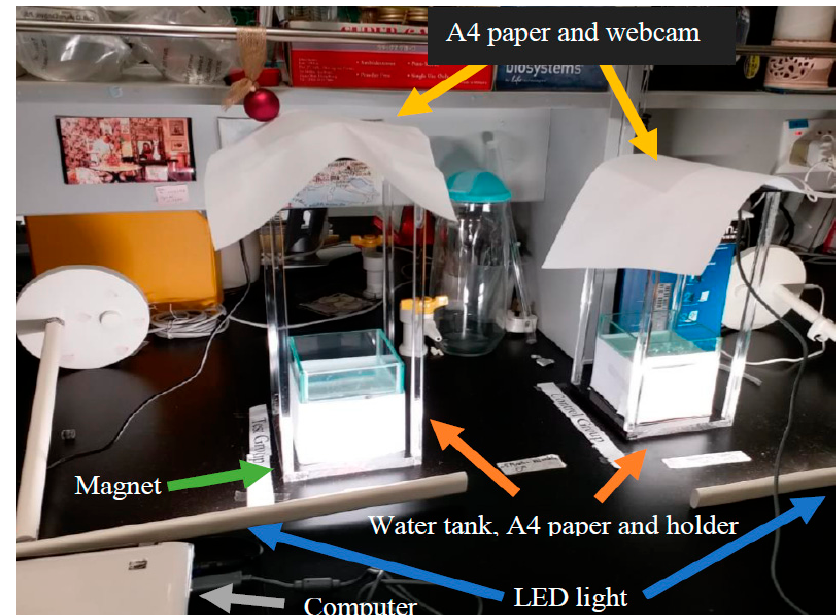
Figure 4. The setup of the experiment.